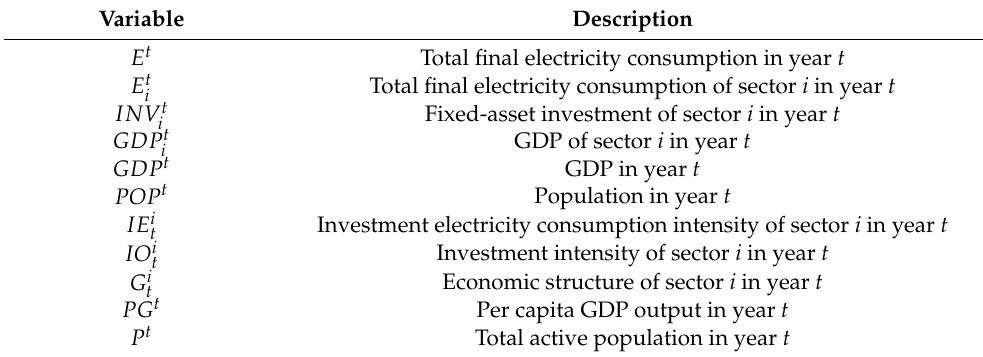
Table 1. Relevant indicators used in the Logarithmic Mean Divisia Index (LMDI)